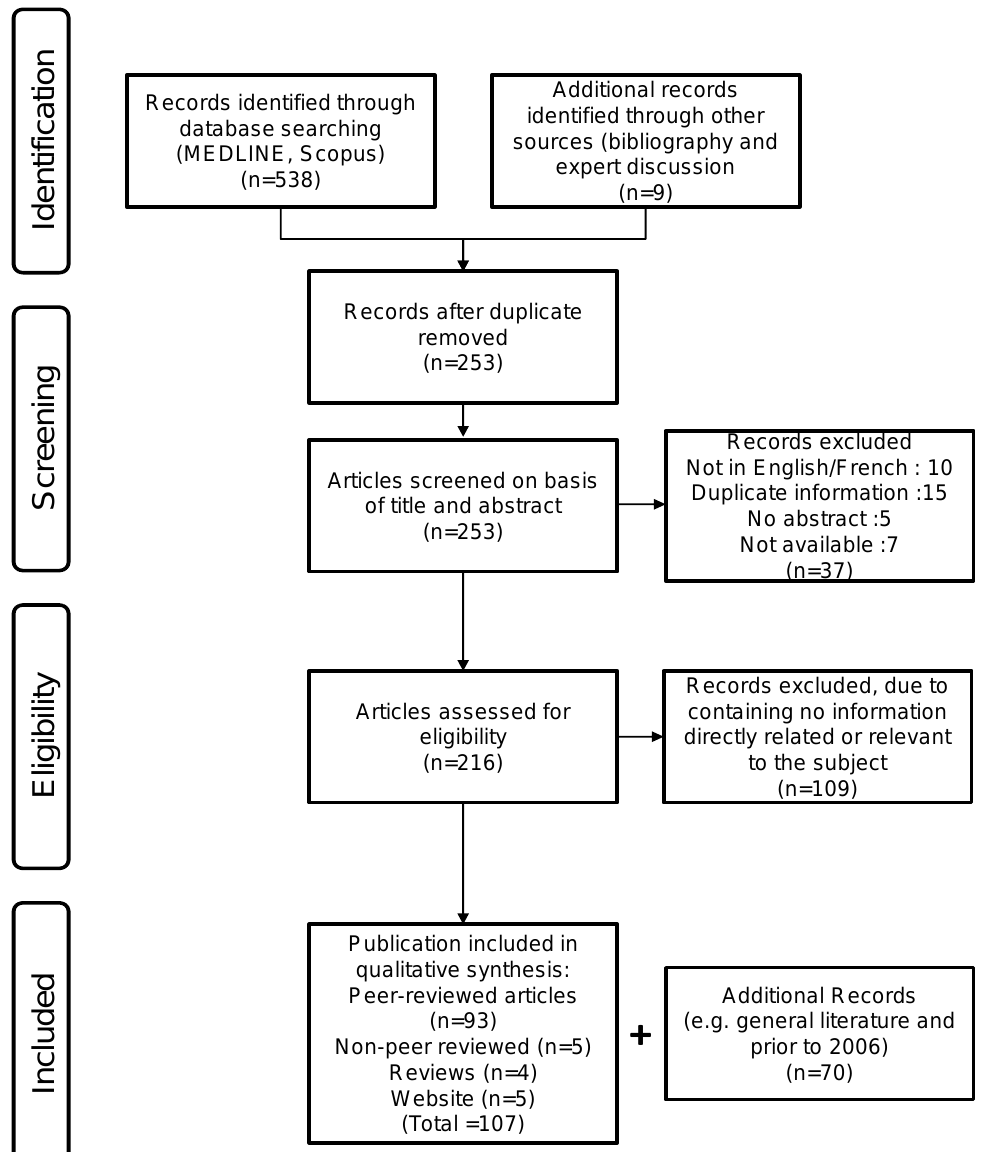
Figure 3. Systematic review